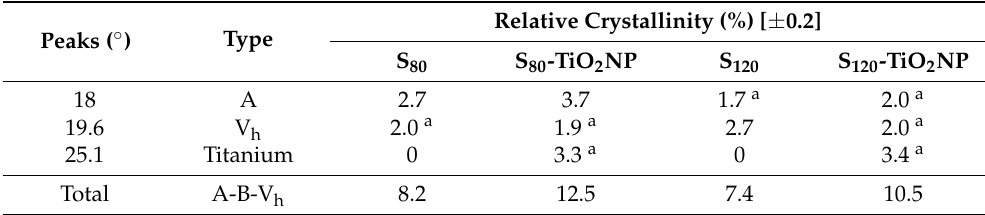
Table 1. Relative crystallinity of the films obtained from the X-ray diffraction patterns. Peaks ( ◦ )